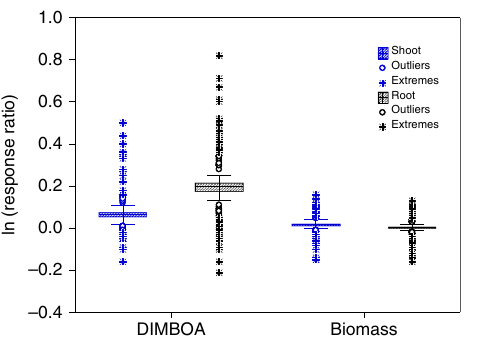
Fig. 2 Biomass and allelochemical response of wheat to the presence of 100 heterospeci fi c neighbors at a 5:5 mixture. Change in biomass or the allelochemical DIMBOA was calculated for each species by ln (T/C), based on the wheat dry weight or allelochemical quantities in wheat-neighbor treatments (T) and in wheat – wheat controls (C). Values equal to controls are represented by 0, greater values indicate increased growth or DIMBOA relative to controls. Box whiskers extend to 1 standard error around the